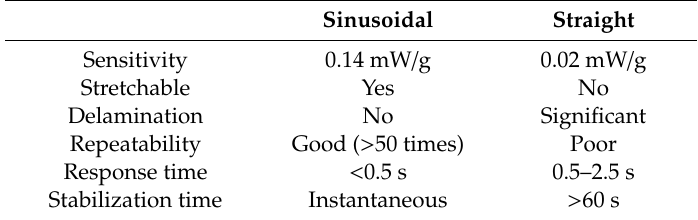
Table 4. Properties of soft robotic gripper with sinusoidal and straight FBG